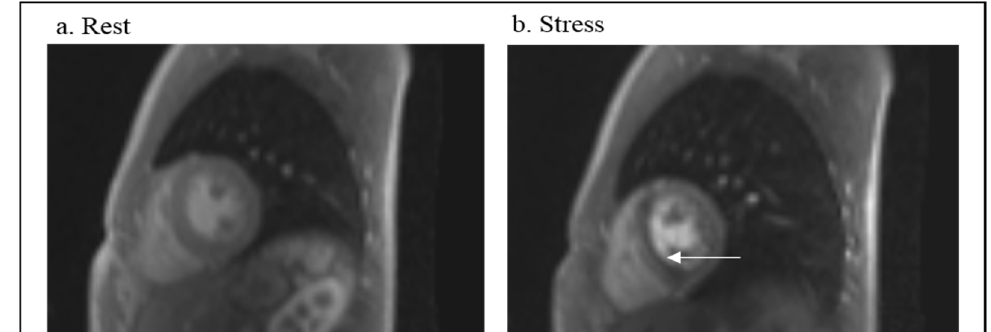
Figure 2. Qualitative assessment of myocardial perfusion deficits. ( a ) demonstrates homogenous myocardial contrast enhancement in the rest state. ( b ) demonstrates a mid- to submyocardial in- ducible perfusion defect (white arrow) during the stress state. This 17-year-old male underwent stress perfusion CMR after undergoing coronary unroofing with creation of a neo-ostium for anomalous left coronary artery arising from the right sinus of Valsalva.